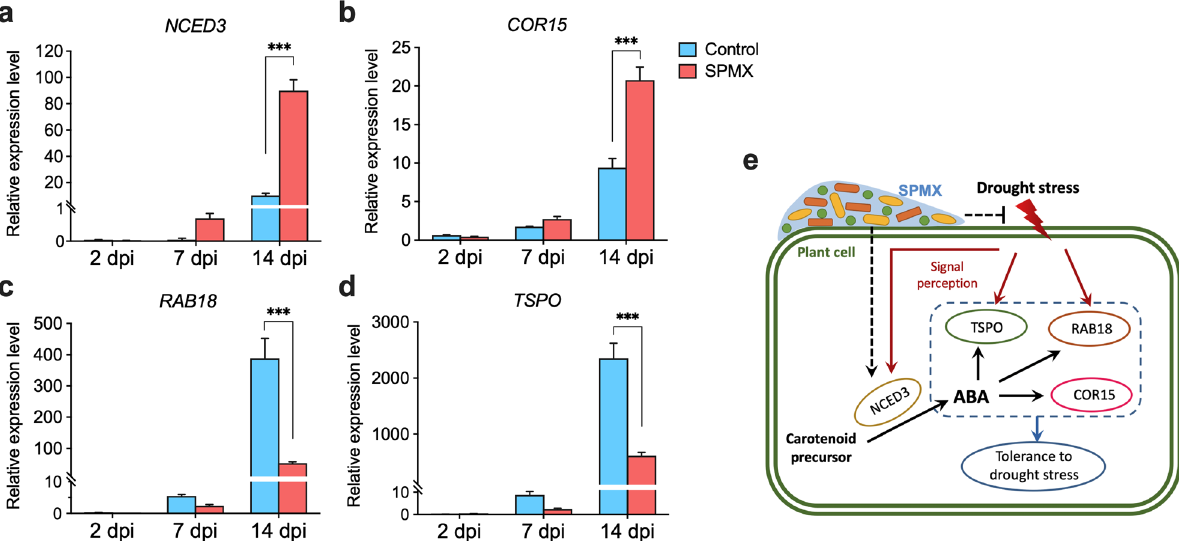
Fig. 3 The relative expression levels of the ABA pathway-related genes under drought when inoculated with SPMX. Differential expression in a ABA-biosynthetic gene NCED3 ; b ABA-responsive gene COR15A ; c drought-responsive gene RAB18 ; d drought-responsive gene TSPO in plants inoculated with and without SPMX (control) at 2, 7, and 14 dpi (relative to the expression level of corresponding genes at 0 dpi). ACT2 was used as an internal control. Error bars represent mean ± standard deviation (three replicates, n = 3). At least two independent replicates showed similar results, with one shown here. e A model suggesting the potential effects of SPMX on ABA-related signaling pathways in response to drought. The regulations of four maker genes NCED3 , COR15 , RAB18 , and TSPO involved in ABA-biosynthetic and ABA- responsive pathways in response to drought, which have been already reported, are shown with solid arrows, while potential in fl uences of SPMX on ABA signaling proposed in the present study are depicted by broken lines. Arrow heads and end lines indicate positive and negative regulation, respectively. Asterisks indicate statistically signi fi cant difference assessed by ANOVA followed by a Tukey HSD test: *** P < 0.001.